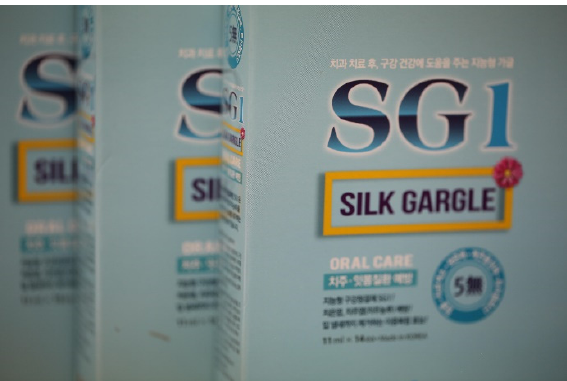
Figure 7. Commercially available oral gargle containing silk proteins.